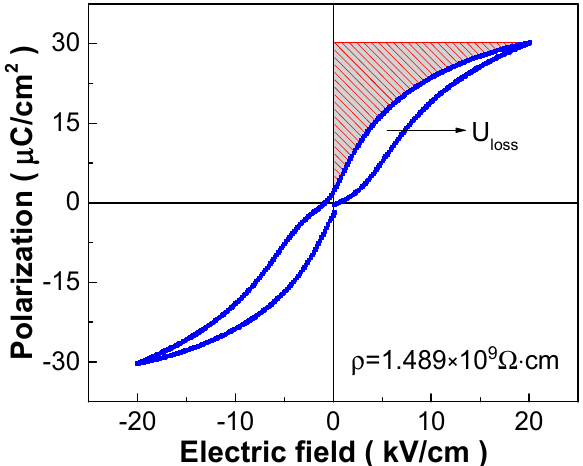
Figure 1. Polarization-electric field (P-E) hysteresis loop of the 0.25 mol% Y 2 O 3 -doped PSLZSnT ceramics. Inset shows resistivity and the shaded area with oblique lines shows the energy-storage density.